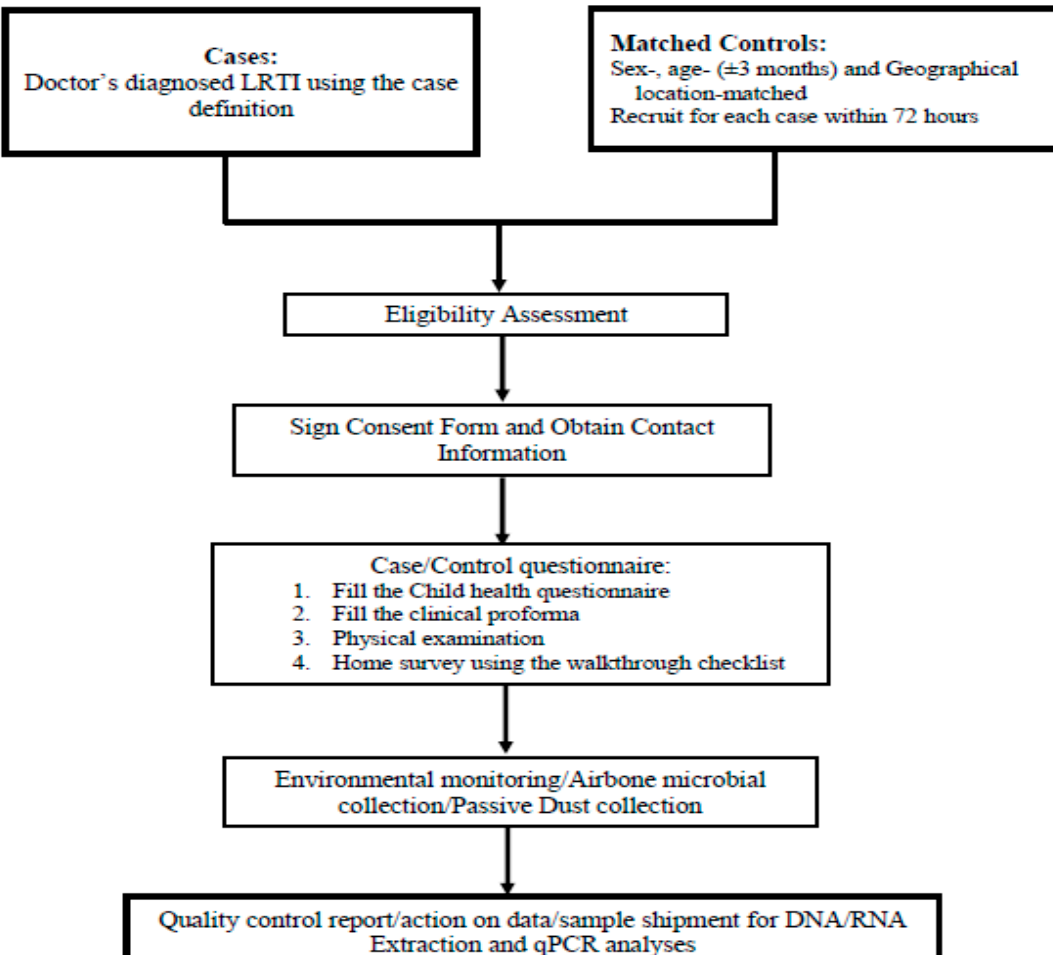
Figure 2. Home assessment of indoor microbiome (HAIM) protocol workflow for cases and controls. LRTI, Lower Respiratory Tract Infections; DNA, Deoxyribonucleic acid; RNA, Ribonucleic acid; qPCR, quantitative polymerase chain